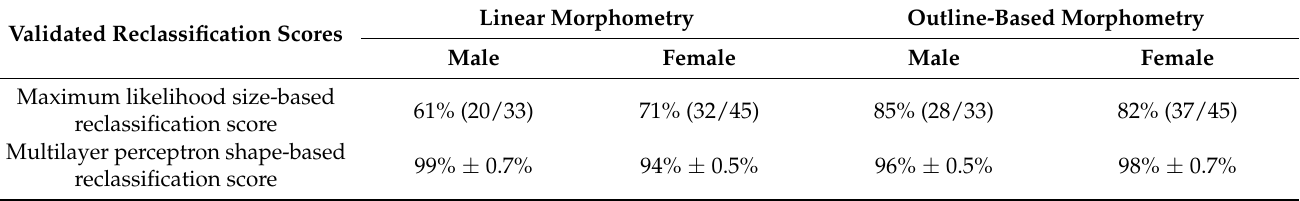
Table 2. Comparison of classification scores based on size and shape for both sexes from traditional morphometry and outline-based morphometry. Total performance is presented as a percentage of